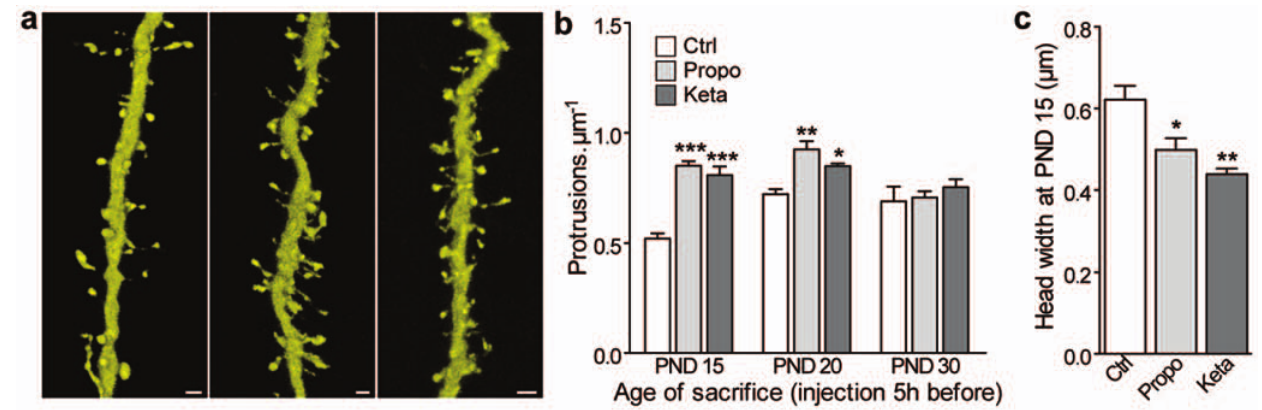
Figure 2. Effects of propofol and ketamine anesthesia on dendritic protrusions in the somatosensory cortex invivo . ( a ) 3D volume rendering of confocal microscopy images of apical dendrites in control (left), propofol-treated (middle) and ketamine-treated (right) PND 15 mice. Scale bars: 1 m m. ( b ) Protrusion density of pyramidal neurons of the SCC of mice sacrificed at PND 15; 20 and 30 just after a 5 h-anesthesia with propofol (Propo) or ketamine (Keta) compared to control conditions (ctrl). ( c ) spine head width at PND 15 after 5 h-propofol (Propo) or Ketamine (Keta) anesthesia compared to control group. (b, c): n =4 animals per group, 6945 spines; ***: P , 0.001, **: P , 0.01, *: P , 0.05, two-way ANOVA with Bonferroni post tests.